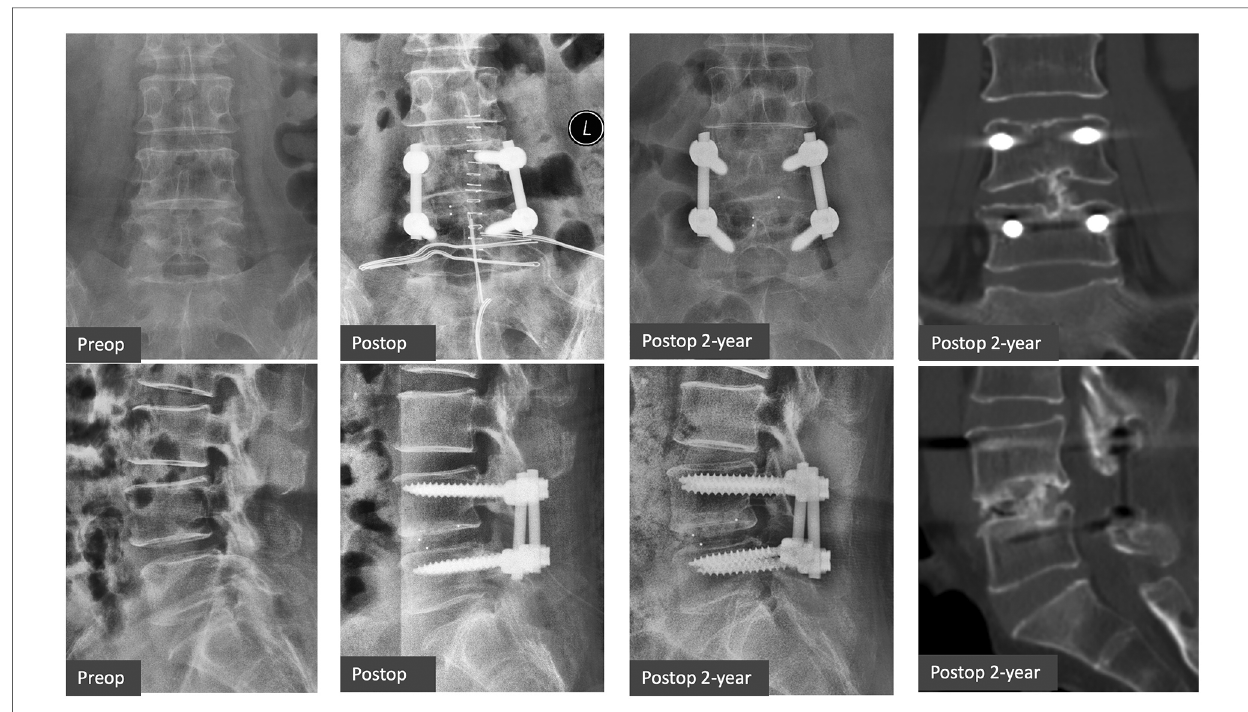
FIGURE 4 Case example of TLIF. A 56-year-old female patient with L4/5 degenerative spondylolisthesis had neurological claudication and low back pain (ODI 50%, VAS-Leg 5, VAS-Back 5). The symptoms were subsided after TLIF (ODI 16%, VAS-Leg 1, VAS-Back 2) at 2 years. Grade 2 fusion (patchy bone bridging) on CT scans was achieved at 2 years. TLIF, transforaminal lumbar interbody fusion; ODI, Oswestry disability index; VAS, visual analog